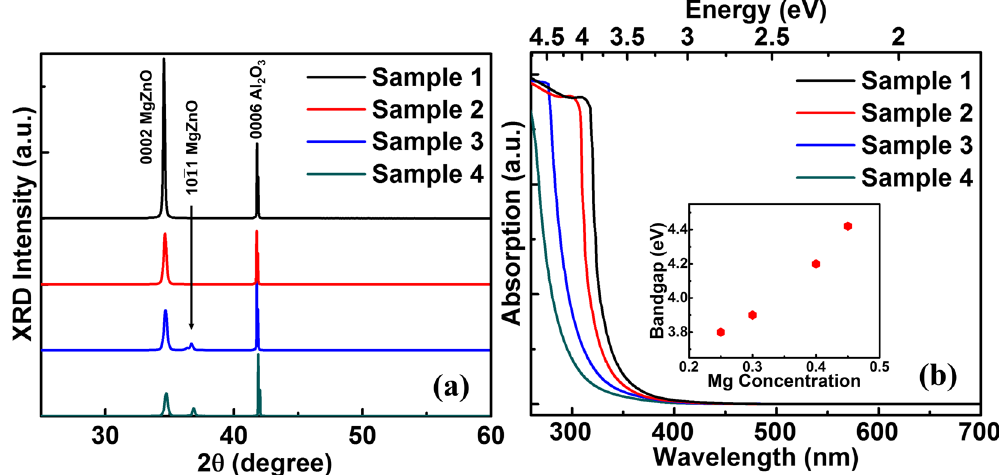
Figure 2. Structural and bandgap properties of MgZnO thin films. ( a ) XRD spectra of MgZnO thin films (Samples 1–4). ( b ) Room-temperature absorption spectra of MgZnO thin films (Samples 1–4), inset shows the variation of bandgap with Mg content in the